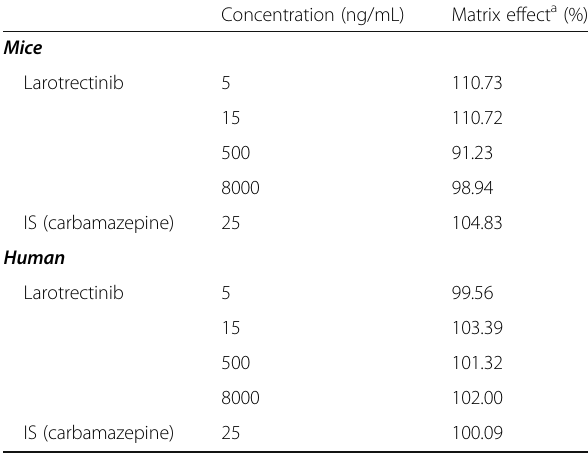
Table 2 Matrix effect of larotrectinib and IS ( n = 5)